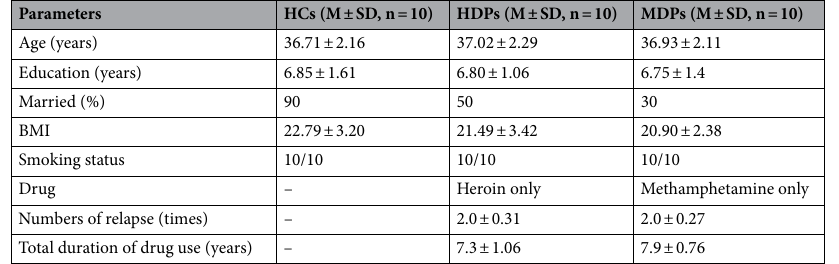
Table 1. Demographics characterisristics of study participants. M mean, SD standard deviation, MDPs methamphetamine-dependent patients, HDPs heroin-dependent patients, HCs healthy controls, BMI Body Mass